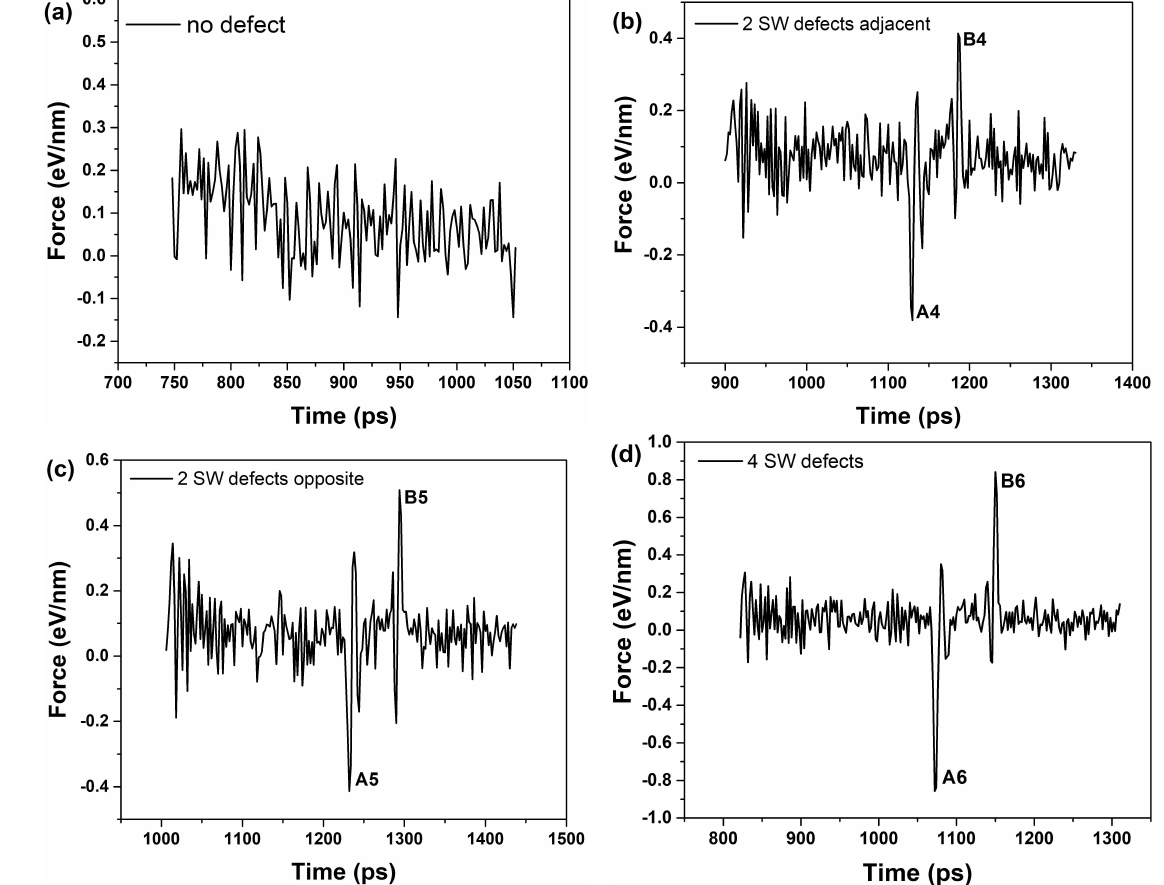
Figure 9: Comparison of the external force acting on the outer tube during the first period of movement for the double-walled system containing no defect, 2 SW defects adjacent, 2 SW defects opposite,4 SW defects in the inner nanotube. The direction of the external force points to the positive direction of the coordinate